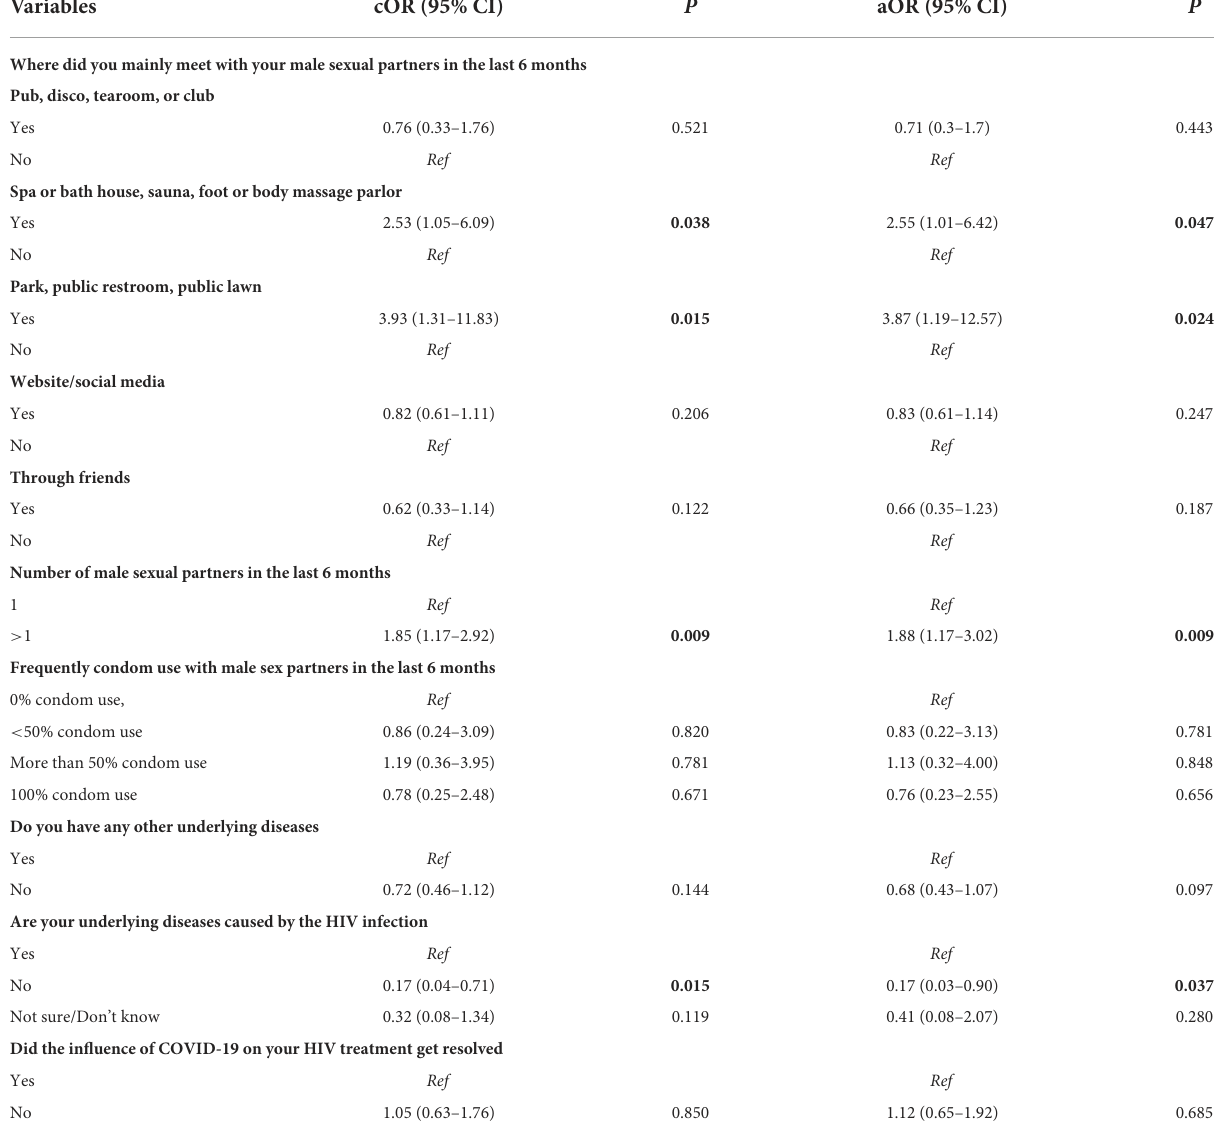
TABLE 4 Factors associated with STD among HIV-positive MSM in Guangdong Province from June 2020 to August 2021 ( N = 944). Variables cOR (95% CI) P aOR (95%